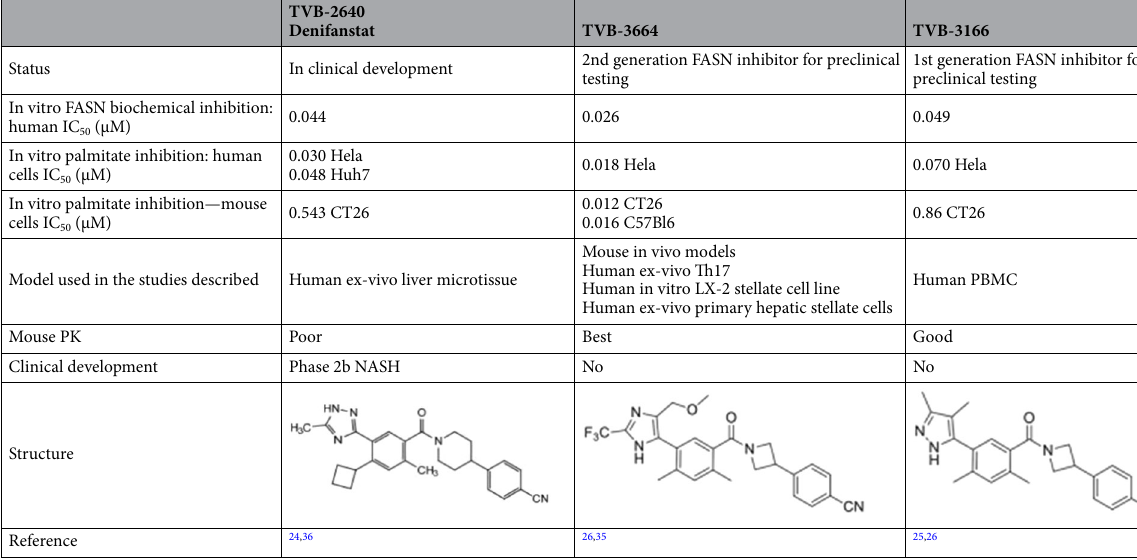
Figure 1. In human in vitro models, FASN inhibition directly reduces cellular triglyceride content, fibrogenic marker expression, pro-inflammatory cytokine production and Th17 cell development. ( a ) Effect of FASNi on TG content in Liver Micro Tissues (LMTs) were treated for 10 days with TVB-2640 in the presence of glucose, insulin and fatty acids, and assayed for TG levels. Mean ± SD of 12 replicates for vehicle and 6 for each TVB-2640 condition. *p < 0.05 by unpaired T test versus vehicle. ( b ) Effect of FASNi on cellular proliferation in LX-2 cells. *p < 0.05 by unpaired T test versus vehicle. ( c ) Effect of FASNi on expression of fibrogenic genes in LX-2 cells. *p < 0.01, **p < 0.05, ****p < 0.0001 by unpaired T test versus vehicle. Quantitative PCR analysis was performed after 48 h of treatment (solid bars) with TVB-3664 followed by washout to remove drug and a further 48 h incubation (striped bars). ( d ) Effect of FASNi on protein expression of Col1α1 and αSMA in LX-2 cells. Immunocytochemistry in cells exposed to 50 or 150 nM TVB-3664 for 48 h. Three independent experiments are indicated by n = 1, 2 or 3. ( e ) Effect of FASNi on protein expression of Col1α1 and αSMA in primary human hepatic stellate cells (hHSC) cells. Immunocytochemistry in cells exposed to 50 or 150 nM TVB-3664 for 48 h. Three independent experiments are indicated by n = 1, 2 or 3. ( f ) Effect of FASNi on Th17 cell development. Flow cytometry analysis of Th17 (IL-17 marker, red circle) and Treg cells (FoxP3 marker, blue circle) cells developed from human CD4+ cells. Two independent human donors are shown, cultured in the absence (DMSO control) or presence of FASNi. ( g ) Effect of FASNi on IL-1β levels in primary human PBMC. Analysis of supernatant after 48 h of treatment with LPS or lipotechoic in the absence or group presence of TVB-3166. Mean/SD. ***p < 0.001 by paired T test versus vehicle.